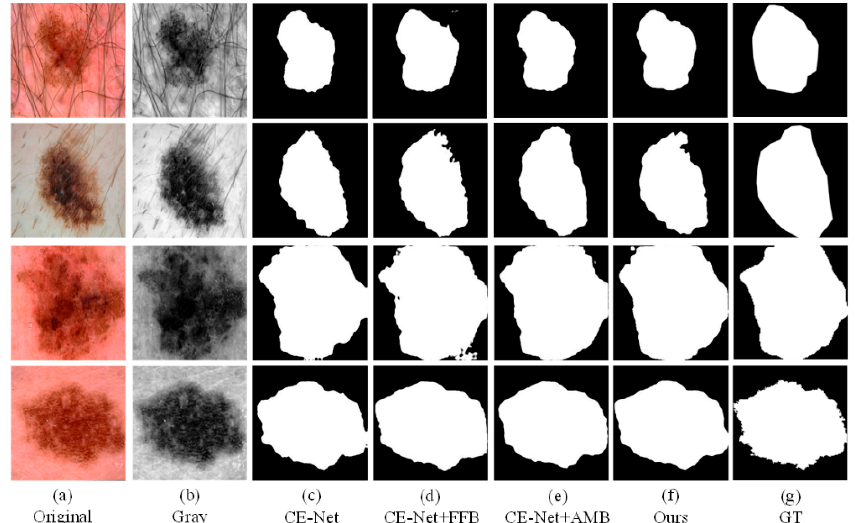
Figure 7. A visualized comparison chart of each network in the ablation experiment. ( a , b ) represent the original image and gray-scale image input into the network compared with ( c , d ). After adding the FFB module, the information obtained by the network is more abundant, and slightly larger than that of the GT diagram. Comparing with ( c , e ), it can be obtained that adding the AMB module can suppress irrelevant information. Comparing ( c – g ), it can be concluded that the network with two modules added at the same time has the best segmentation